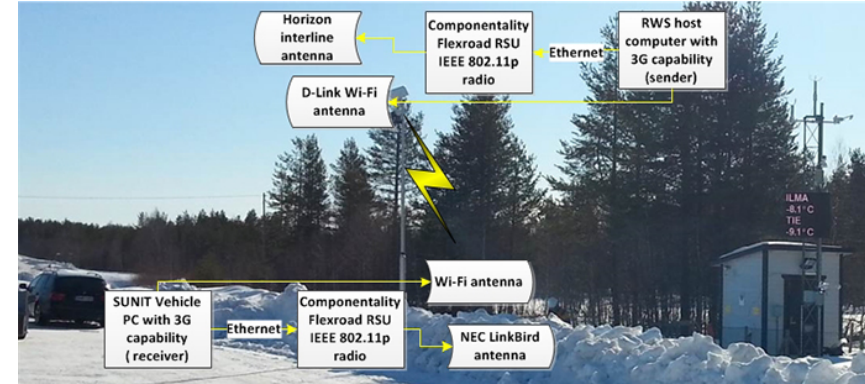
Figure 5. Devices and their connections in IEEE 802.11p communication.